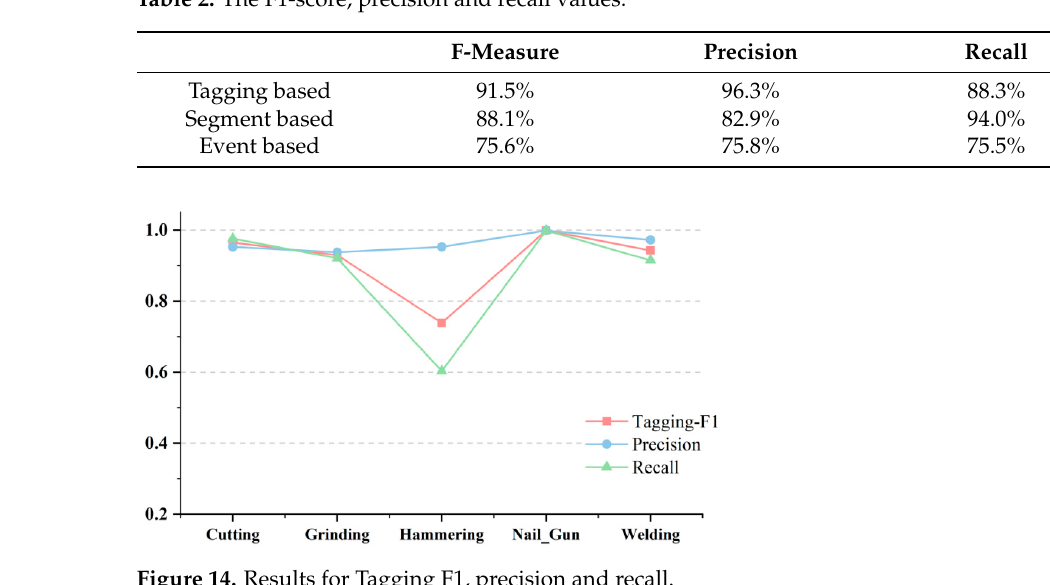
Figure 15. Results for Segment F1, precision and recall. Figure 16. Results for Event F1, precision and recall. As can be seen from Figure 14, Nail_ Gun achieved the highest Tagging F1-score of 99.9%, which was followed by Cutting, Welding, and Grinding, with scores of 96.5%, 94.3%, and 93.0%, respectively. Hammering’s Tagging F1-score was only 73.9%, which